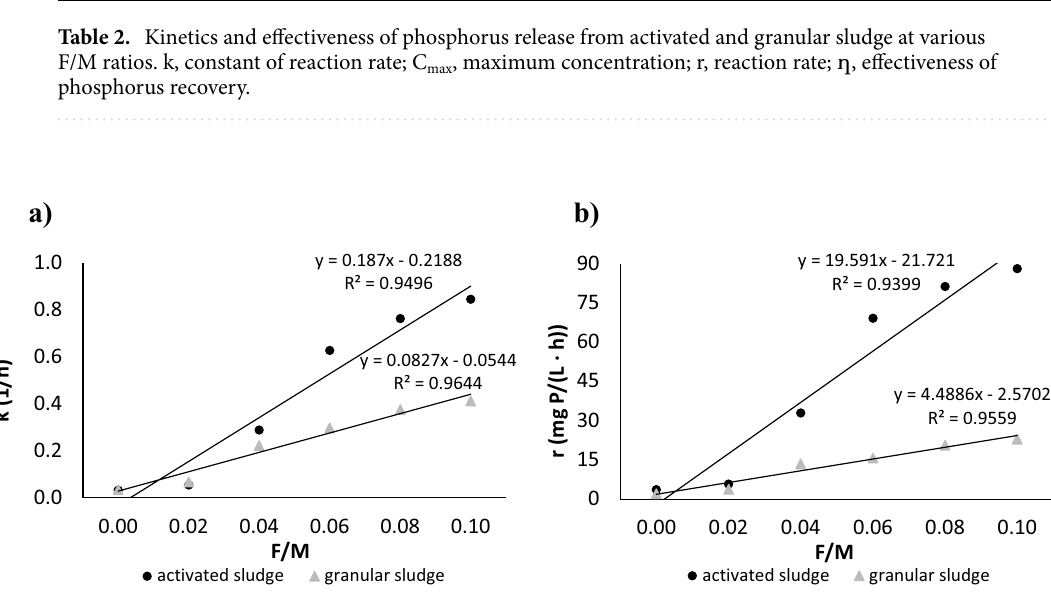
Figure 1. Relationship between the F/M ratio at the beginning of the experiment and ( a ) rate constants for phosphorus release and ( b ) reaction rate of phosphorus